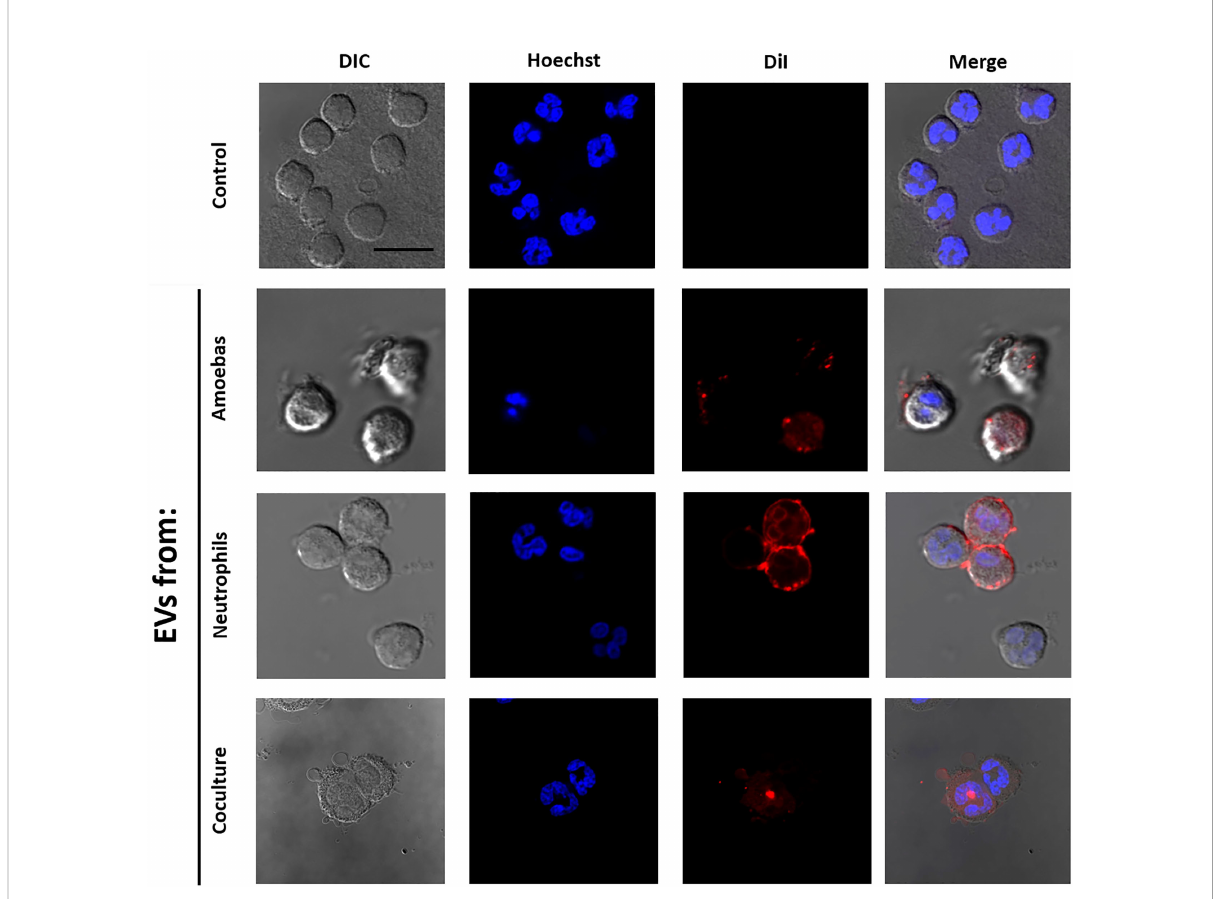
FIGURE 2 Interaction of EVs with human neutrophils. EVs were isolated from E. histolytica trophozoites, neutrophils or coculture; then, EVs were stained using DiI and added to neutrophil (2 x 10 5 ) cultures. After 10 min of interaction, neutrophils were fi xed, stained with Hoescht (5 µg/ml), and mounted for visualization using Fluorshield ™ . Neutrophils in the absence of exosomes were used as control. Scale bars represent 20 µm and all fi gures are in the same magni fi